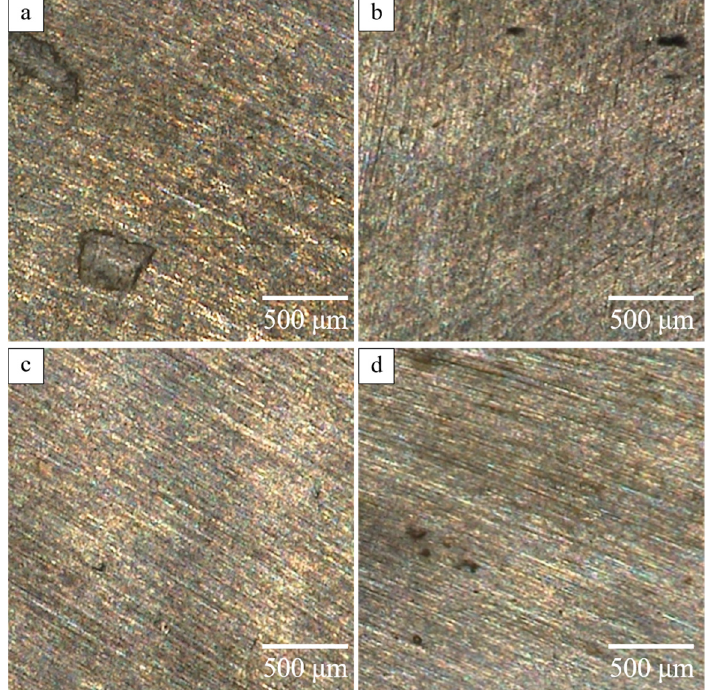
Figure 10. The morphologies of the welding zone of 316L stainless steel samples after salt spray corrosion with different numbers of laser shock peening : ( a ) substrate, ( b ) peening once, ( c ) peening twice, and ( d ) peening three times.